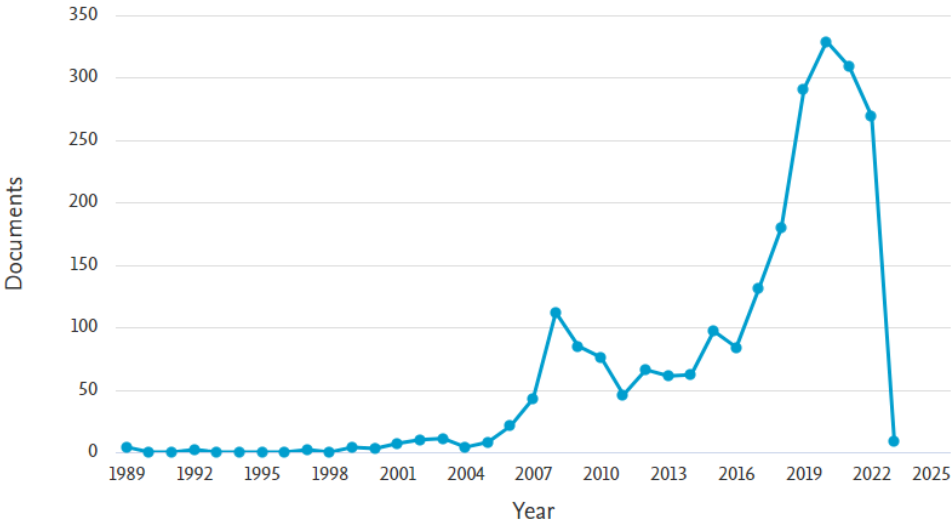
Figure 2. Documents by years for “machine learning” AND “knowledge management”.